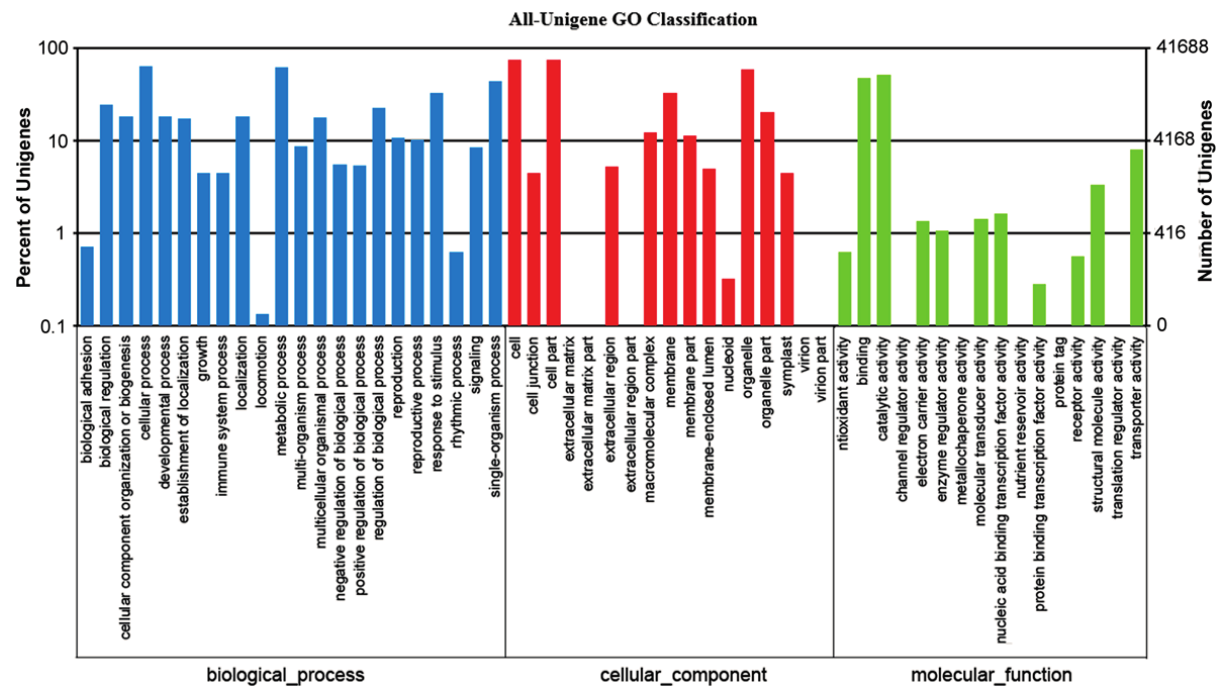
Figure 5. Histogram of gene ontology (GO) classification. The results are summarized in three main categories: Biological processes ( blue ), cellular components ( brown ) and molecular functions ( green ). The y -axis on the right side indicates the percent of unigenes in a category, and the y -axis on the left side indicates the number of